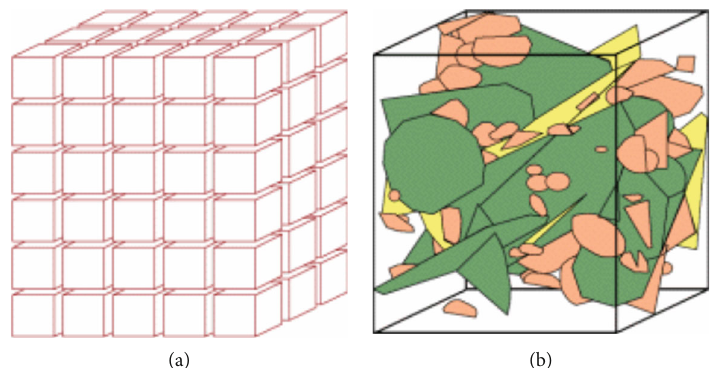
Figure 1: Warren-Root model (a) and DFN model (b).